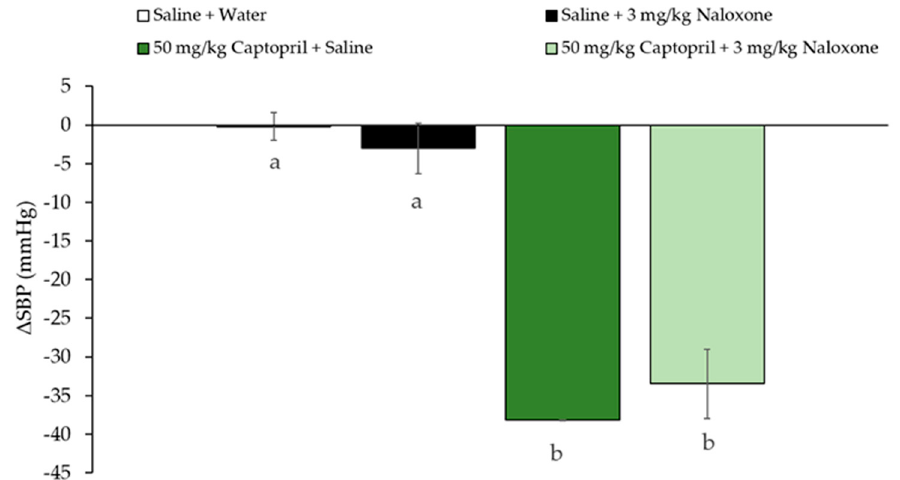
Figure 3. Changes in systolic blood pressure (SBP) caused in spontaneously hypertensive rats after 6 h post-administration of the different treatments: oral administered water + intraperitoneal injected saline, orally administered saline + intraperitoneal injected 3 mg/kg bw Naloxone, oral administered 50 mg/kg bw Captopril + intraperitoneal injected saline or orally administered 50 mg/kg Captopril + intraperitoneal injected 3 mg/kg bw Naloxone. Data are expressed as mean ± standard errors. The experimental groups always had six animals each. Different letters represent statistically significant differences ( p < 0.05). P was estimated by one-way ANOVA.